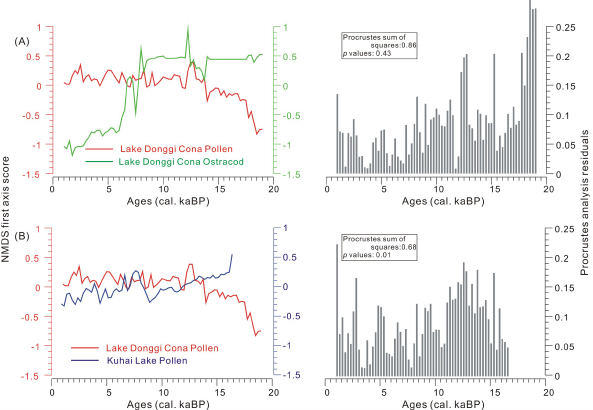
Fig. 7. Non-metric multidimensional scaling (NMDS) axis 1 scores (left) and diagram of Procrustes analysis results (right) comparing pollen and ostracod data from Lake Donggi Cona (A) , and compar- ing pollen data from Lake Donggi Cona with data from Lake Kuhai (B) . The analyses were based on data sets harmonised over 250yr intervals.